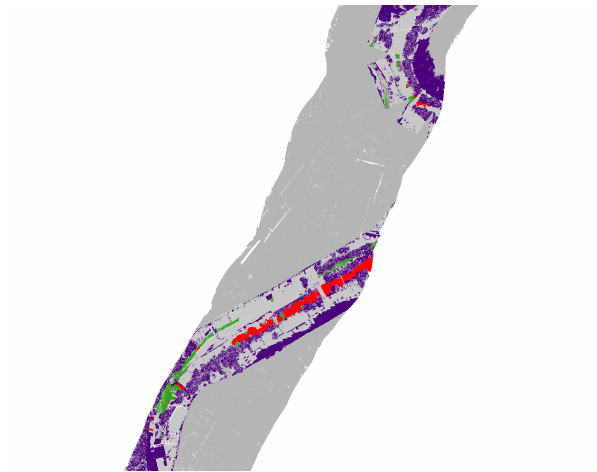
Figure 8. GT for assigned labels.